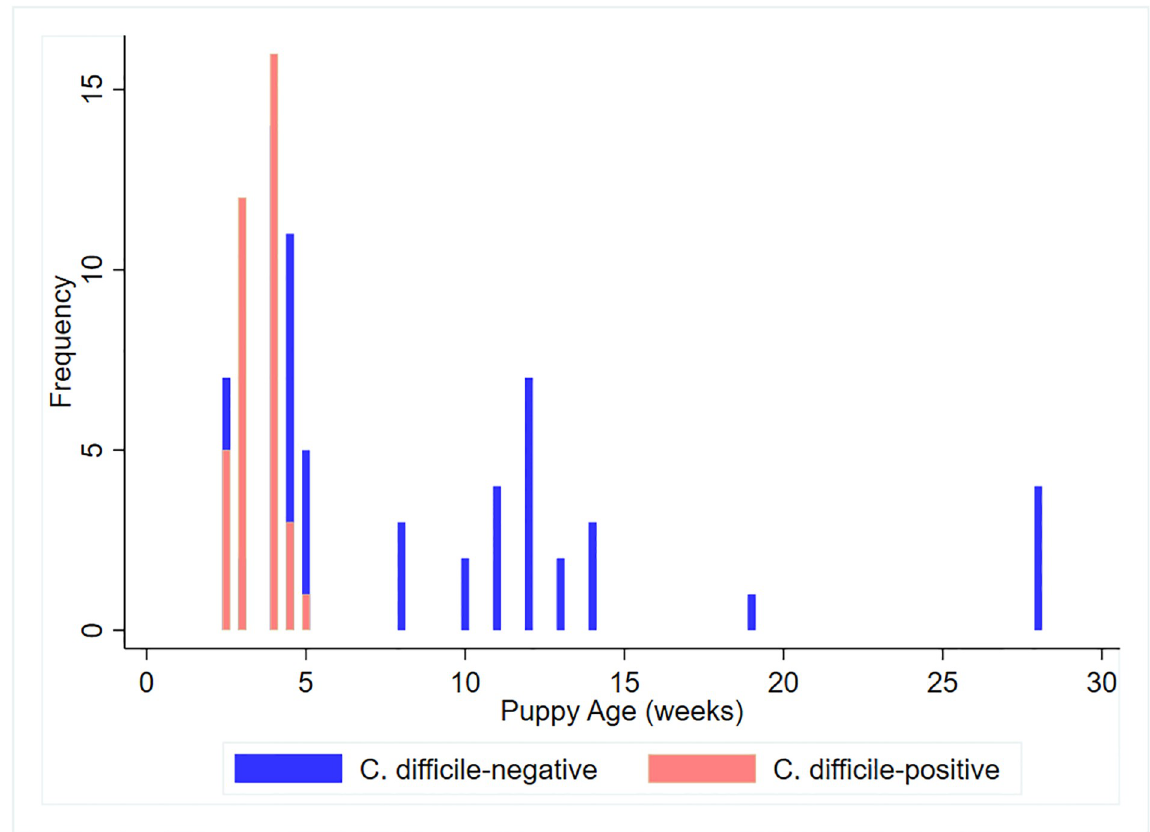
Fig 1. Distribution of the ages of puppies sampled in the greater Philadelphia